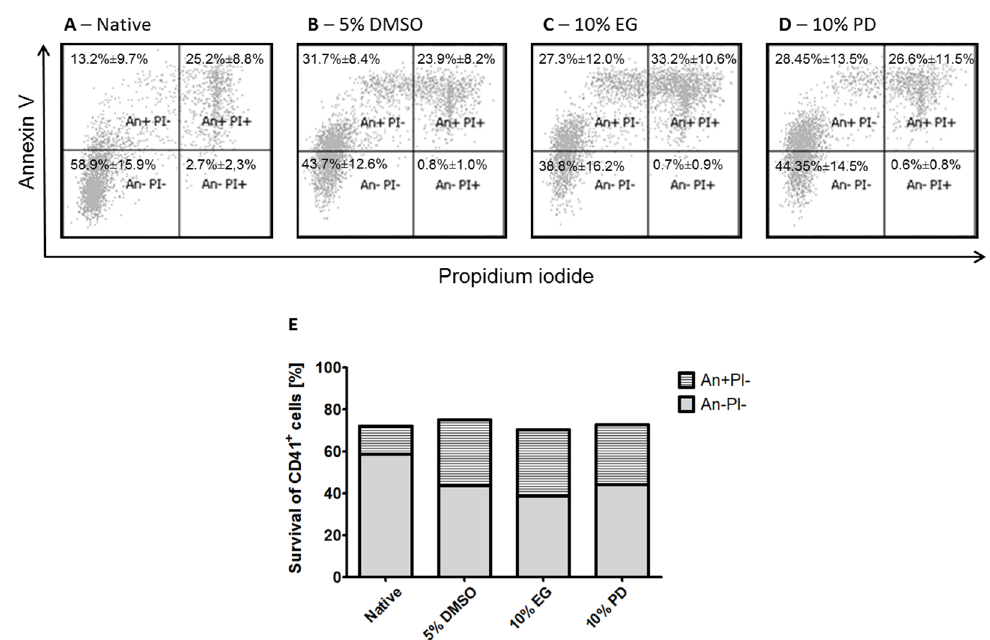
Figure 2. Levels of necrosis and apoptosis in the in vitro iPSC-derived MK cell populations before and after cryopreservation. Staining with Annexin V and PI analyzed with flow cytometry. MKs stained with anti-CD41 antibody. Representative dot plots before ( A ) and after (( B )—5% DMSO; ( C )—10% EG; ( D )—10% PD) cryopreservation. The data is presented as mean ± SD. ( E )—Total percentages of MKs with potential contribution to the cell survival. The data is presented as a sum of means of MK cells detected negative for both necrotic and apoptotic events with means of MK cells negative for necrotic, but positive for apoptotic events.